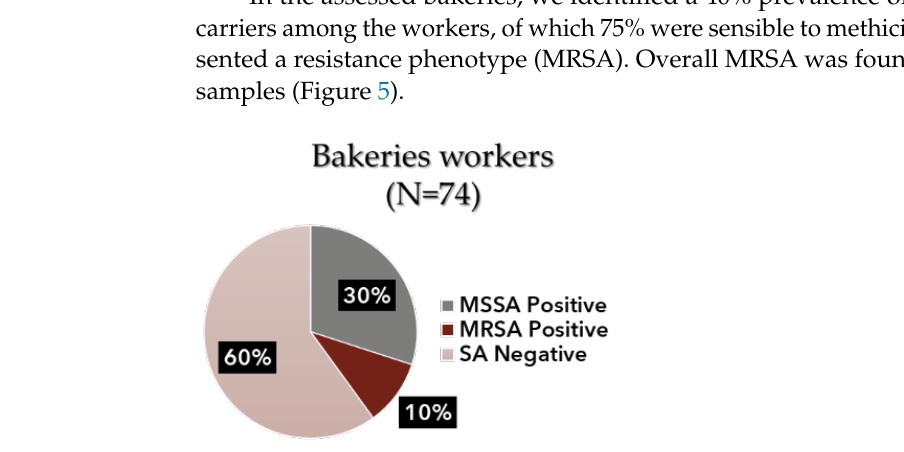
Figure 5. MRSA prevalence in the bakery workers .